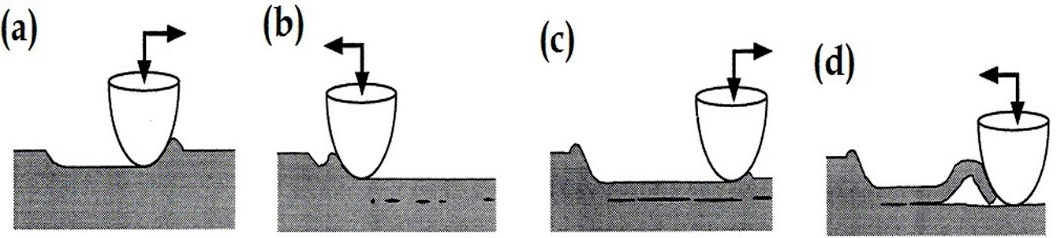
Figure 8. Schematic illustration of the delamination during the wear test at the ( a ) starting, ( b , c ) middle and ( d ) reciprocating wear round.